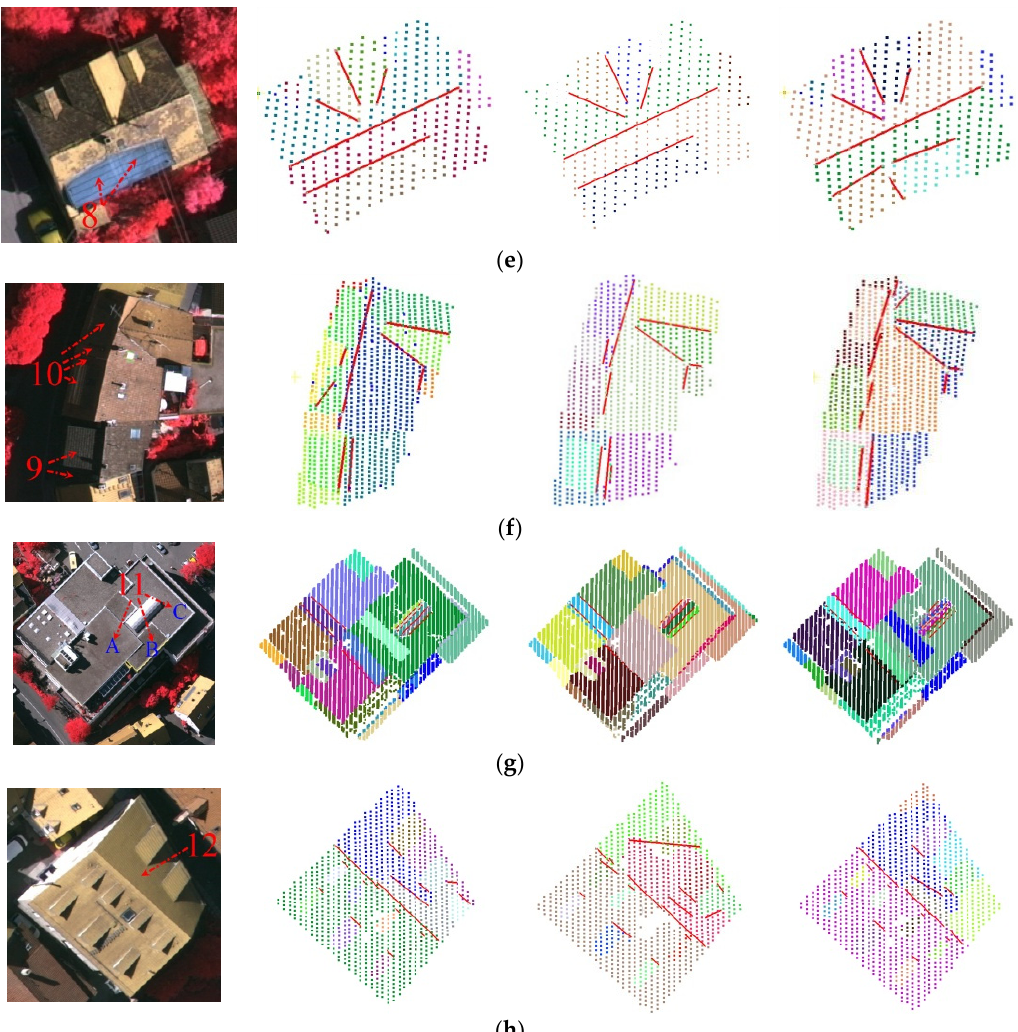
Figure 8. Results of segmentation and ridge detection for error-prone buildings. ( a – h ) are eight selected buildings containing error-prone regions. From left to right: reference images, results by classical RANSAC, results by RG, and results by BDSAC nv .